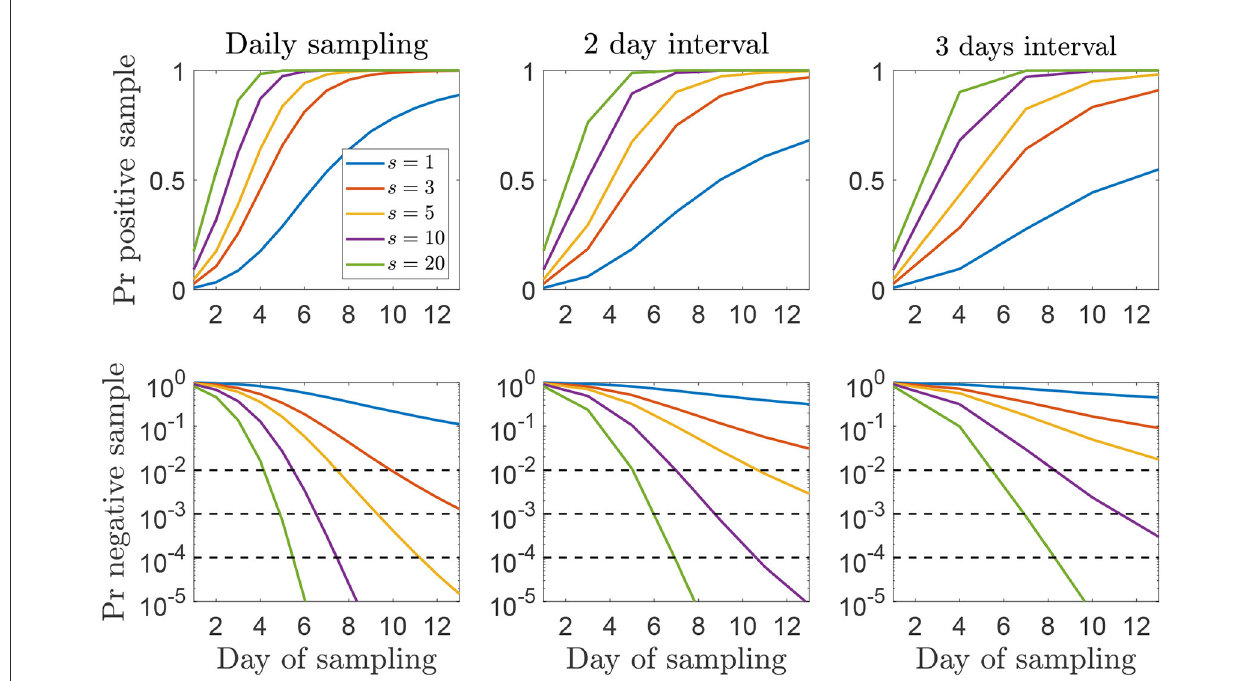
FIGURE7 (Top) The cumulative probability of detecting FMDV at least once with different sampling strategies on an IP. (Bottom) The probability that all samples have tested negative up to and including the day of sampling if a premises is infected. The line color indicates the number of samples taken at each sampling interval, s (see legend). The three dotted lines are at 1, 0.1, and 0.01% which correspond to a 99, 99.9, and 99.99% confidence of a negative result. The first sampling day after infection is drawn from the distribution shown in Figure 6.